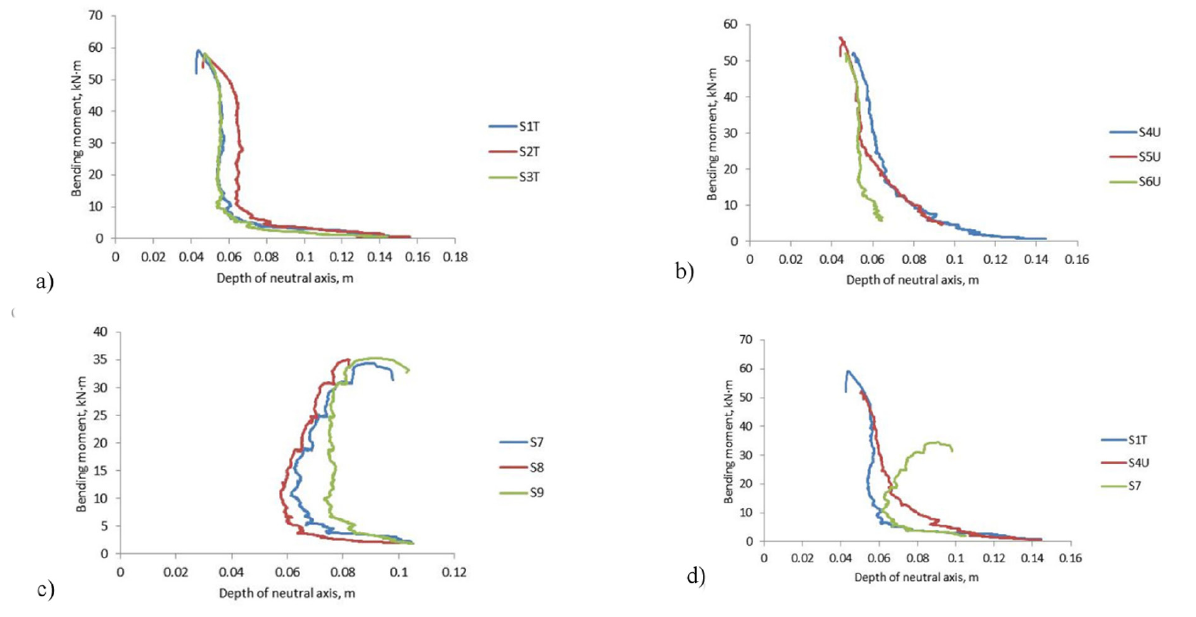
Fig. 10. Variation of the depth of the neutral axis: (a) SxT beams, (b) SxU beams, (c) Sx beams; (d) comparison between the S1T, S4U, and S7